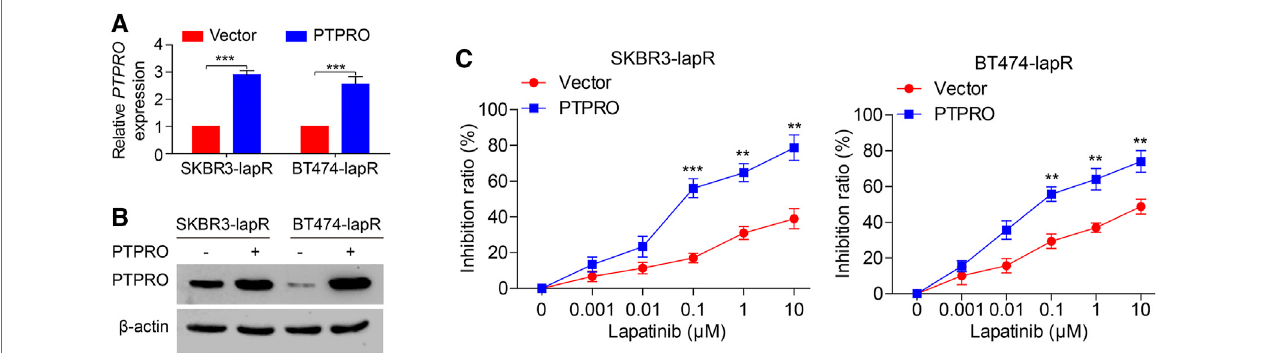
FIGURE 4 | PTPRO sensitizes lapatinib in ERBB2-positive breast cancer cells. (A) The level of PTPRO mRNA in SKBR3-lapR and BT474-lapR cells with PTPRO overexpression were analyzed by RT-qPCR. (B) The protein level of PTPRO in SKBR3-lapR and BT474-lapR cells with PTPRO overexpression were analyzed by Western blot. (C) Cell inhibition ratio analysis of SKBR3-lapR and BT474-lapR cells with PTPRO overexpression was evaluated by MTT assay, 72 h after treatment with 10-foldserialdilutionsoflapatinibrangingfrom0.001to10 μ M.Datawereshownasthemeansofthreeindependentexperimentsorrepresentativedata.Errorbars indicate SEM. ** p < 0.01, *** p < 0.001 by one-way ANOVA with post hoc intergroup comparisons, where